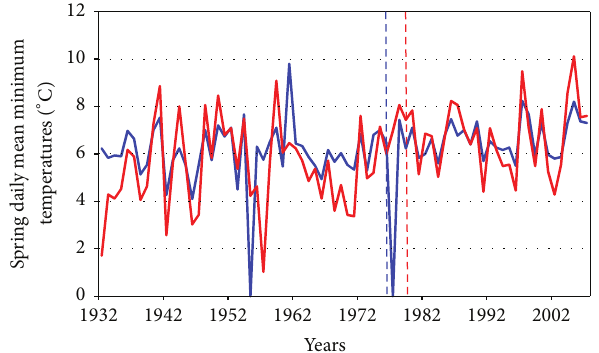
Figure 2: Comparison of the temporal variability of mean mini- mum daily spring temperatures at the Joliette (agricultural water- shed, blue curve) and Saint-Michel-des-Saints (forested watershed, red curve) stations. The vertical bar indicates the year in which the significant change in the mean took place.